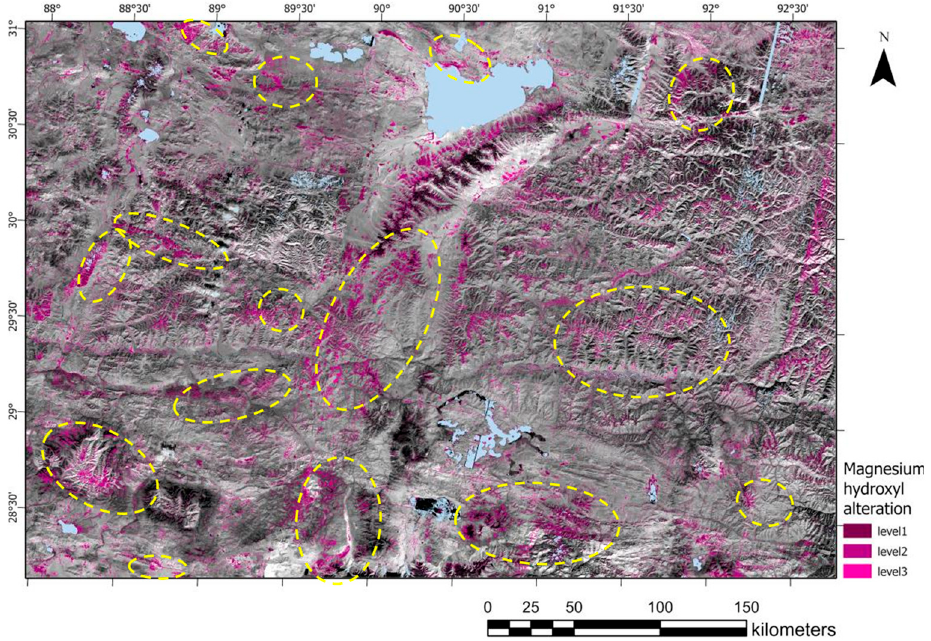
Figure 13. Mg hydroxyl alteration map of the Gondwana region obtained by the EPCA method. (The yellow dashed boxes in the figure indicate the more pronounced spatial aggregation of alteration information.)